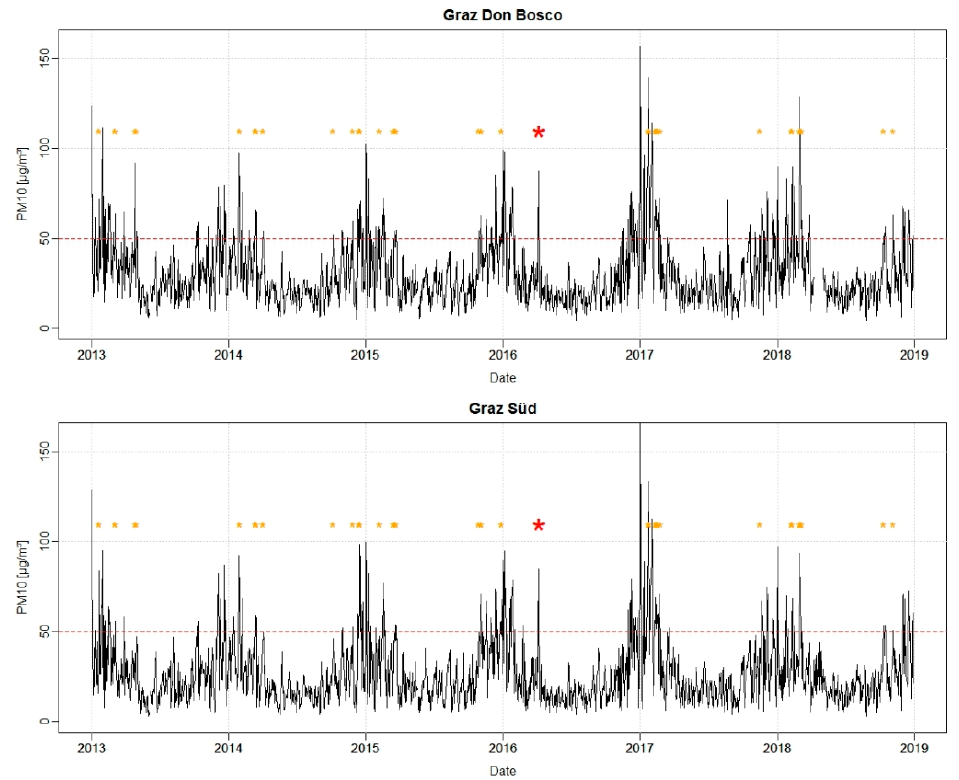
Figure 2. Particulate matter (PM 10 ) time series of the two stations under investigation. The red line marks the 50 µg/m³ limit value set by the European Commission. Orange stars mark desert dust events on days where the PM 10 concentration was > 50 µg/m³. The red star marks an intense Saharan dust event in April 2016.